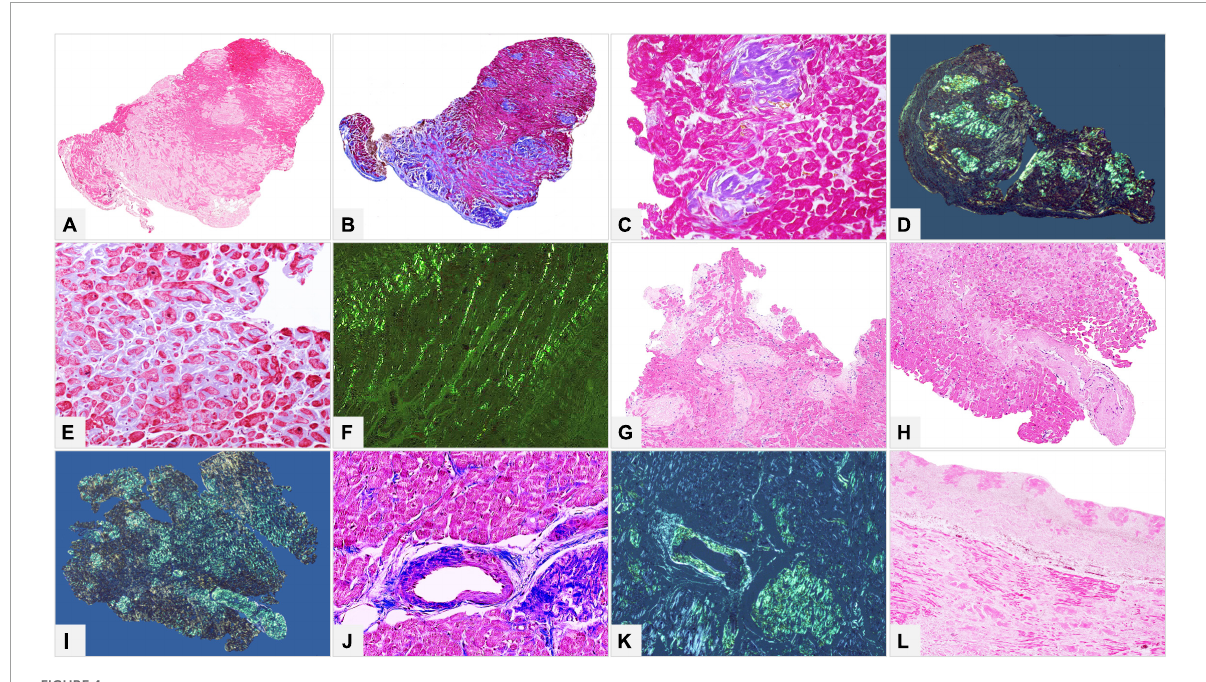
FIGURE4 (A–K) Endomyocardial biopsies of patients with AL and ATTR. (L) Atrial sample of native heart of a patient transplanted for ATTR. (A,B) Myocardial interstitial mixed pericellular and nodular patterns diffusely distributed throughout the biopsy fragment. (C,D) Myocardial micronodular pattern, where amyloid aggregates replace the myocardium. (E,F) Myocardial interstitial pericellular pattern, made up of thin amyloid deposits around cardiomyocytes. (G–K) Amyloid deposits within mural arteries involving both intima and medial layers with circumferential (G–I) or focal (J,K) distribution. (L) Nodular amyloid deposits within subendocardial fibrous thickening. (A) Hematoxylin-Eosin 50 × . (B) Azan Mallory trichrome 50 × . (C) Azan Mallory trichrome 200 × . (D) Congo red under polarized light 50 × . (E) Azan Mallory trichrome 200 × . (F) Congo red under polarized light 200 × . (G,H) Hematoxylin-Eosin 100 × . (I) Congo red under polarized light 50 × . (J) Azan Mallory trichrome 200 × . (K) Congo red under polarized light 100 × . (L) Hematoxylin-Eosin 50 ×